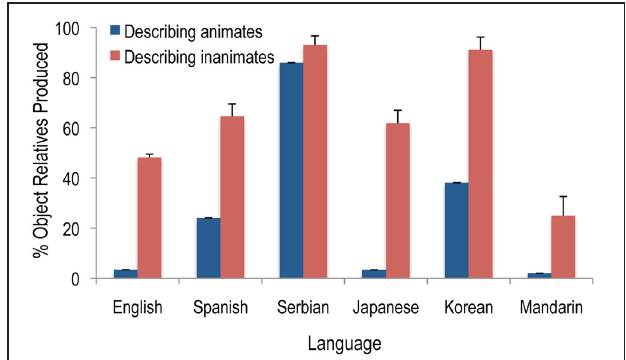
FIGURE 1 | The frequency with which object relative clauses are produced to describe animate and inanimate entities in a picture description task, calculated as a percentage of all relative clauses produced. The English, Spanish, and Serbian data are from Experiments 1a, 2, and 3 of Gennari et al. (2012), respectively. The Japanese data are from Montag and MacDonald (2009), Korean from Montag et al. (in preparation), and Mandarin from Hsiao and MacDonald (in